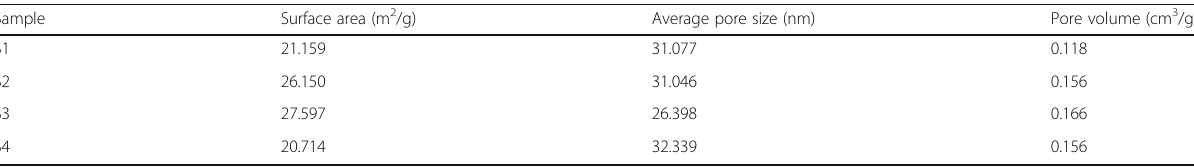
Table 1 Textural properties of porous microsphere measurements of S1, S2, S3, and S4